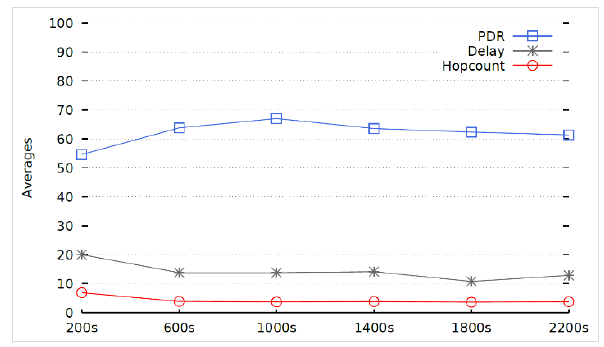
Figure 5. The GGCE multi-greedy method performance for different forwarding durations